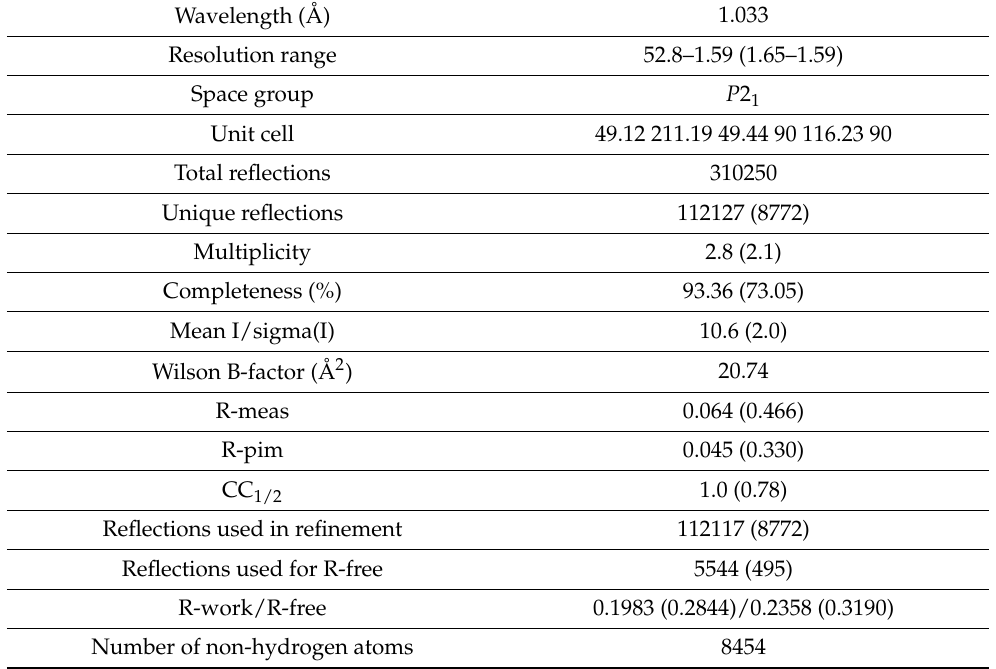
Table 1. X-ray data collection and refinement